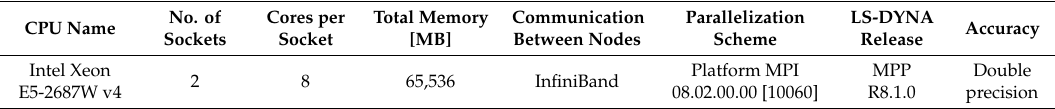
Table 3. Specifications of computational nodes and software used for all simulation scenarios.